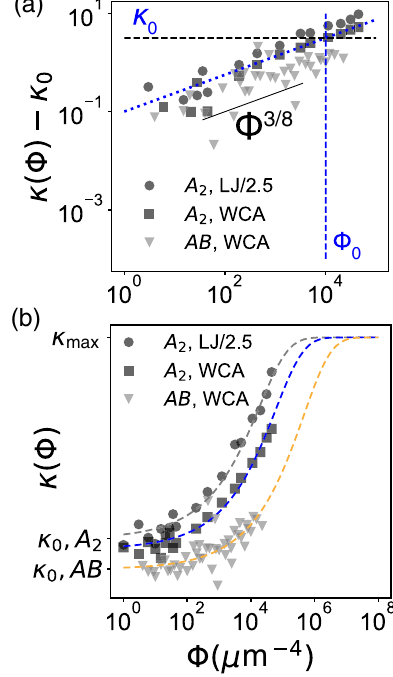
FIG. 4. Empirical rate law: (a) κ ð Φ Þ − κ 0 increases as κ 1 Φ ϵ , with ϵ ¼ 3 = 8 , for the Φ values considered in our simulations (blue dotted line). κ 0 is the concentration-independent rate, and Φ κ Φ 3 = 8 ¼ κ 0 is the mass-action flux where 1 0 . (b) This scaling is 0 used to postulate a sigmoidal κ ð Φ Þ . The parameters of the sigmoidal functions are κ 0 , κ , and Φ 0 (see text for details). max We use the postulated sigmoidal function as an empirical rate law for Φ values both encountered and not encountered in the molecular simulation. To fit these curves, we use κ 0 ¼ 4 . 2 μ m 2 s − 1 and Φ ¼ 5 × 10 3 for A 0 2 in the presence of LJ interaction (dashed gray); κ 0 ¼ 3 . 7 μ m 2 s − 1 and Φ 0 ¼ 1 × 10 4 for A 2 in the presence of WCA interaction (dashed blue); κ 0 ¼ ¼ 1 × 10 5 for AB in the presence of WCA 3 . 2 μ m 2 s − 1 and Φ 0 interactions (dashed orange). The values of κ 0 are obtained by ¼ averaging κ ð Φ Þ values for Φ < 30 for D ¼ 1 μ m 2 = s and r a 1 . 2 r [Fig. min